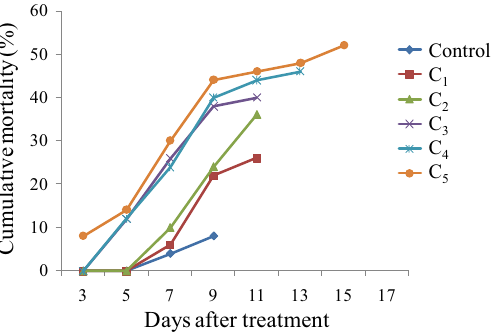
Figure 4. Mean cumulative mortality of second instar larvae of S. litura fed on castor leaves treated with different concentrations (C 1 = 4.6 × 10 8 cfu/ml, C 2 = 8.9 × 10 8 cfu/ml, C 3 = 1.8 × 10 9 cfu/ml, C 4 = 3.4 × 10 9 cfu/ml and C 5 = 6.1 × 10 9 cfu/ml) of E. mundtii .